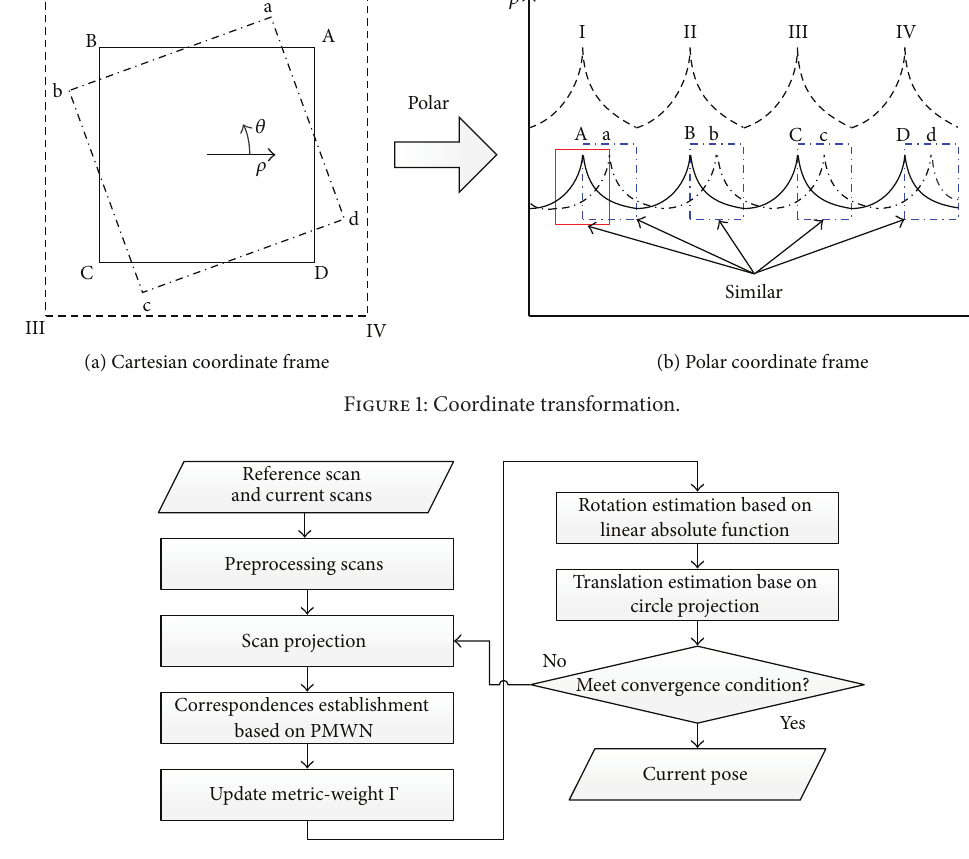
Figure 2: Algorithm of scan matching in this